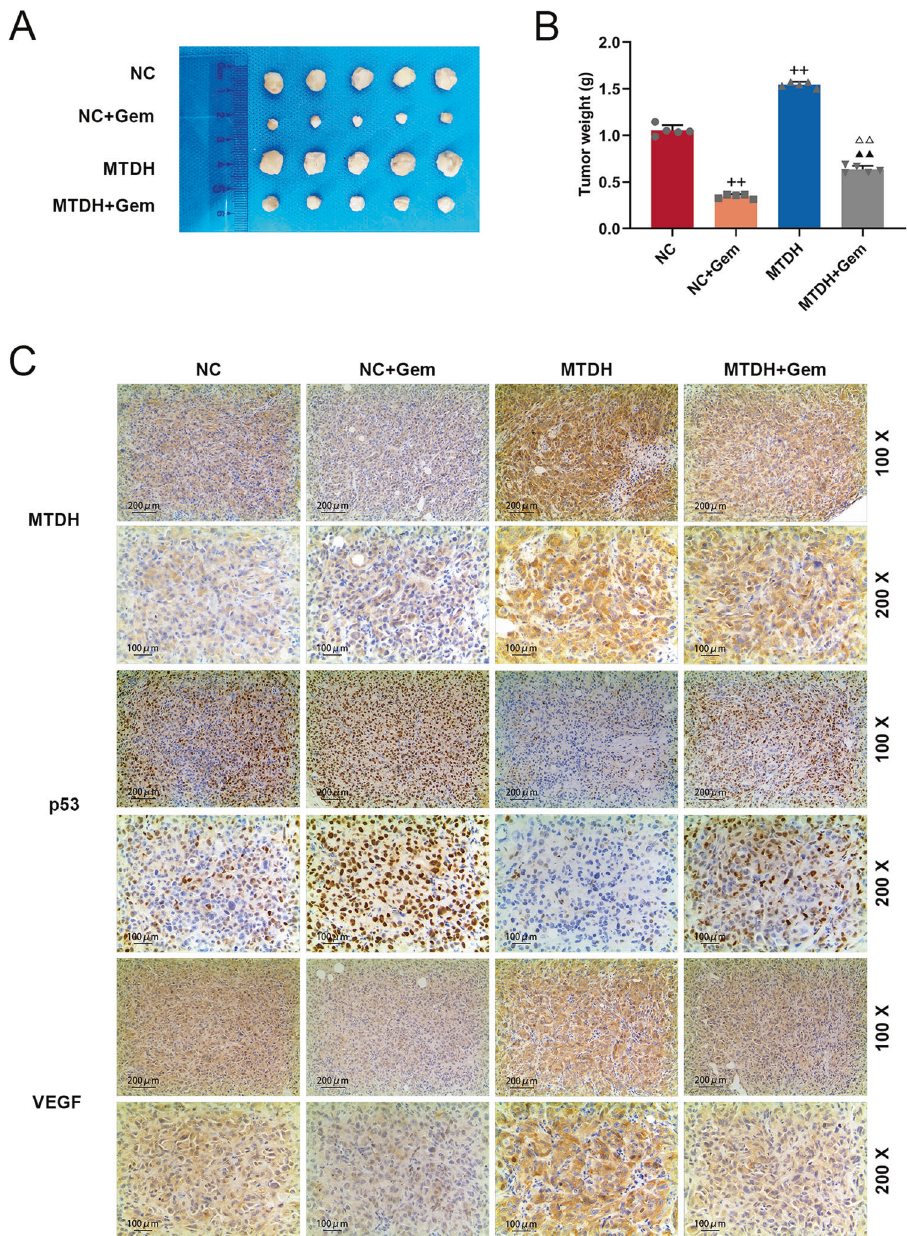
Fig. 5 The effects of MTDH on the tumor growth and protein expression in Gem-treated tumor mice. Mouse tumor-bearing model was established and the mice were treated by MTDH and Gem, the size ( A ) and weight ( B ) of tumors were measured ( n = 3, ++ P < 0.01, vs. NC; ▲▲ P < 0.01, vs . NC + Gem; △△ P < 0.01, vs. MTDH). C Immunohistochemistry was used to detect the expressions of MTDH, p53, and VEGF in tumor tissues. VEGF vascular endothelial growth factor, MTDH Metadherin, NC negative